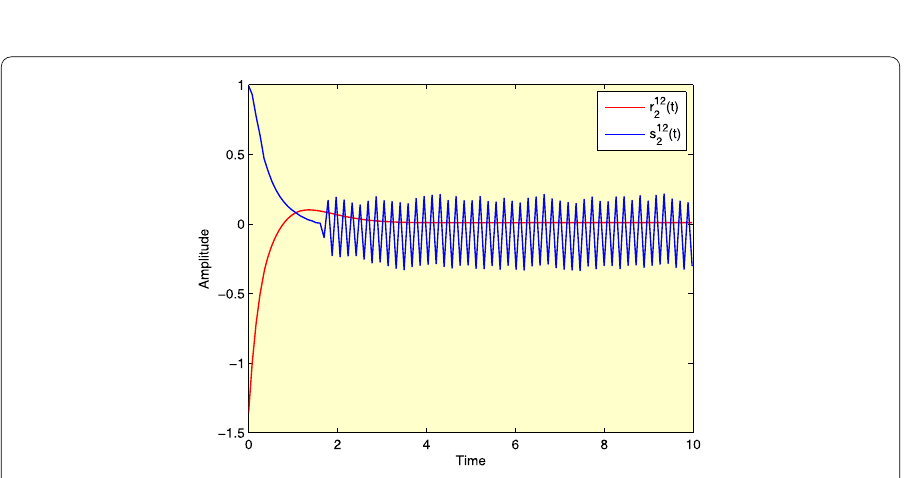
Figure 11 Time responses of state variables r 12 2 ( t ), s 12 2 ( t ) of NN models (1) and (3)